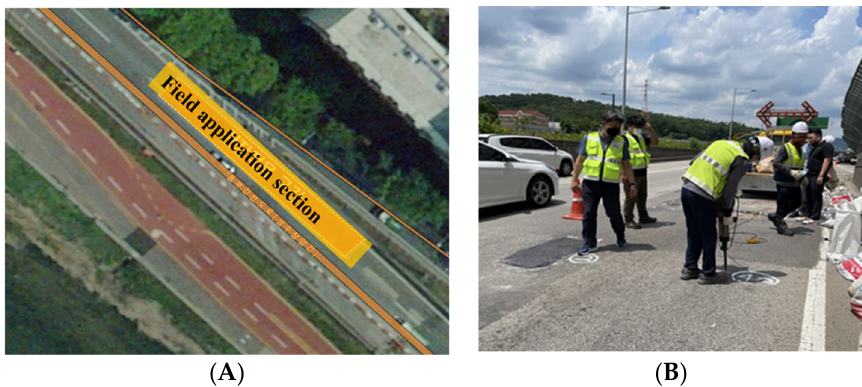
Figure 6. ( A ) Field application location and ( B ) view of the construction site.